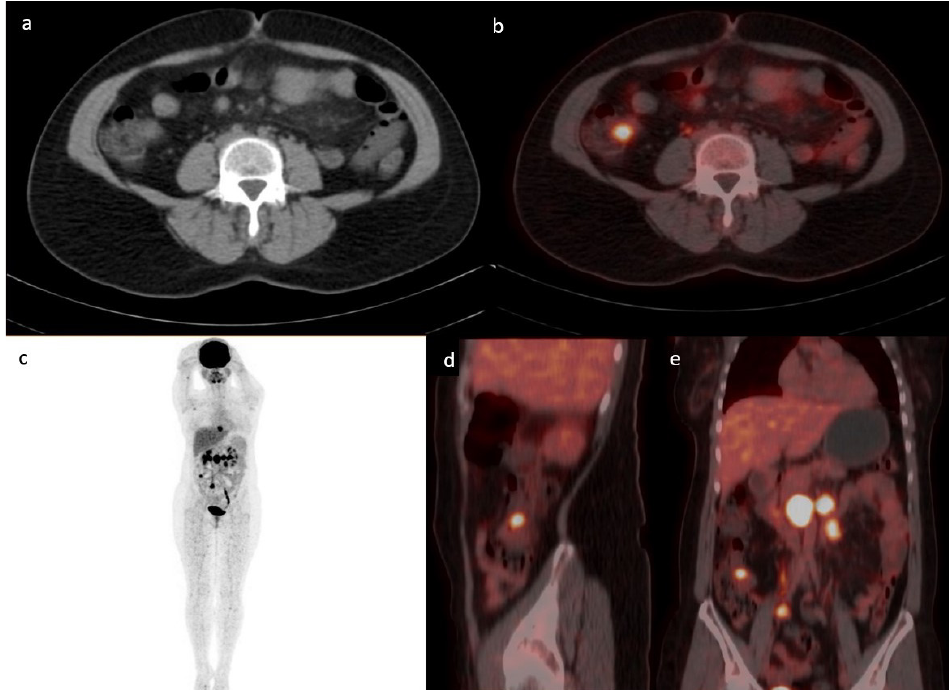
Figure 2. Case of a 43-year-old female with a history of follicular lymphoma. Axial CT ( a ) fused with PET ( b ) showing a focus of increased uptake at the level of the ileocecal valve with an SUVmax of 7.1 corresponding to a 1.7 cm soft tissue density. MIP ( c ) showing multiple active supra and infra diaphragmatic lymph nodes. The infra diaphragmatic lymph nodes are seen again in the fused sagittal ( d ) and coronal ( e )-fused PET/CT images. The patient underwent a colonoscopy where ileal biopsy showed non-necrotizing granulomas, with no evidence of lymphoma or micro-organisms.